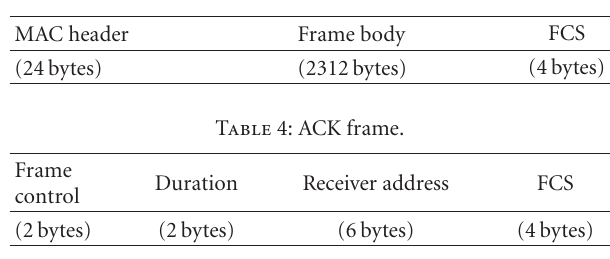
Table 3: Medium access control data unit.